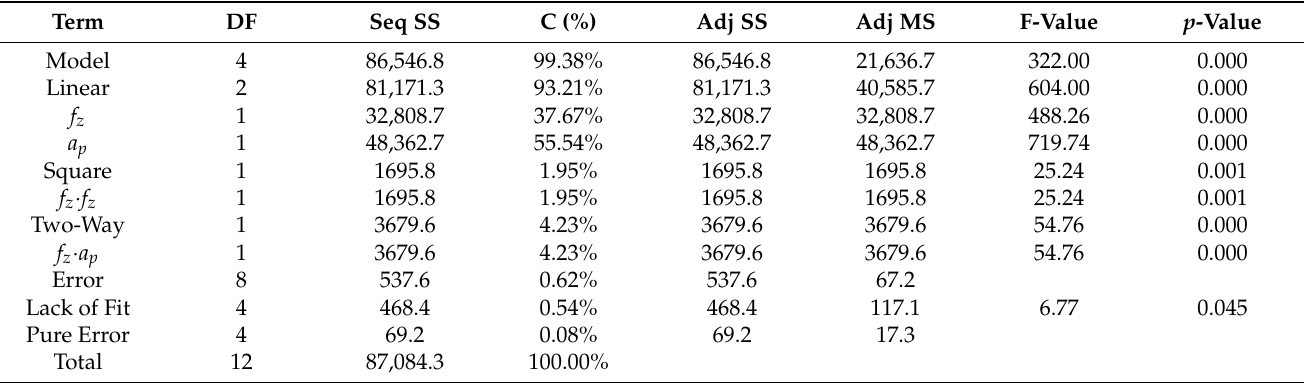
Table 5. Analysis of variance for the F f cutting force component